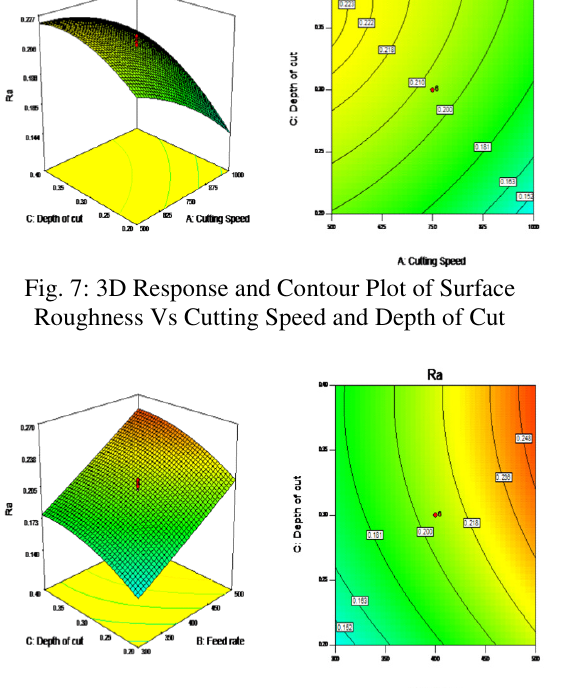
Fig. 8: 3D Response and Contour plot of Surface Roughness Vs Feed Rate and Depth of